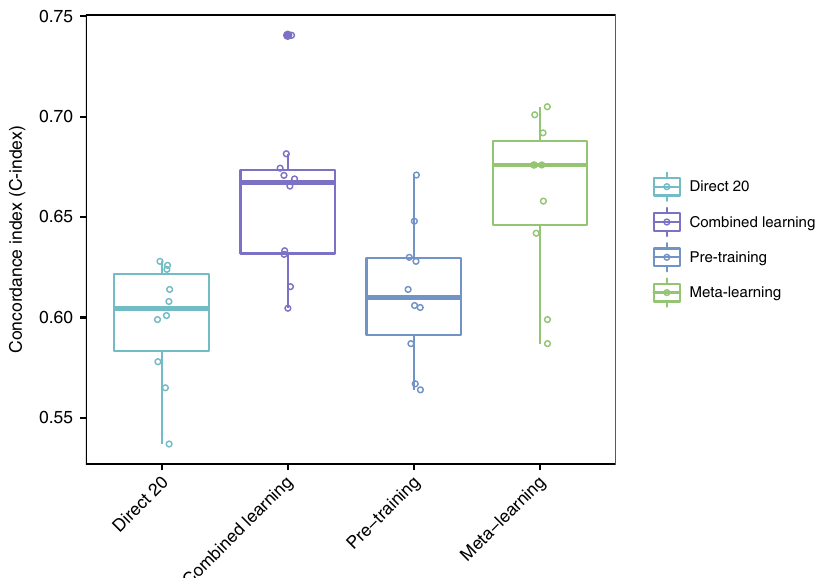
Fig. 6 C-Index for survival prediction on the mesothelioma cohort, comparing small (20) size sample direct learning, combined learning, regular pre- training, and meta-learning. n = 45 testing samples from mesothelioma cohort over 10 independent experiments. The upper and lower bars in the box- plots represent the largest and smallest data points excluding any outliers. The upper and lower bounds of the boxes represent the 25th percentile and 75th percentile of the data, respectively. The middle bars represent the median of the